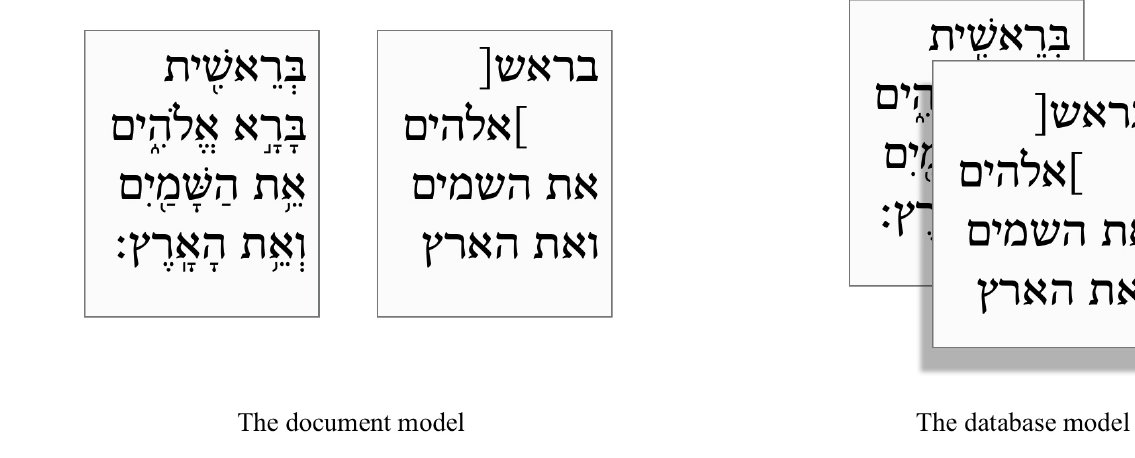
Figure 2: Two-dimensional text in the document model vs. three-dimensional text in the database model Texts become like transparency sheets, and we can compare texts by layering one on top of the other to see where they line up. To add another text to the database, we simply assign the appropriate already- existing characters to another set of hierarchies; the new text is instantly related to other texts already in the database. By contrast, a comparison of multiple manuscripts in the document model would require the creation of many duplicate character strings with links between them. Instead of one single bêt reused in every instance of bərēʾšît in every manuscript, as we have in the database model, we would have as many bêt ’s as we have manuscripts, with a giant web of links to relate